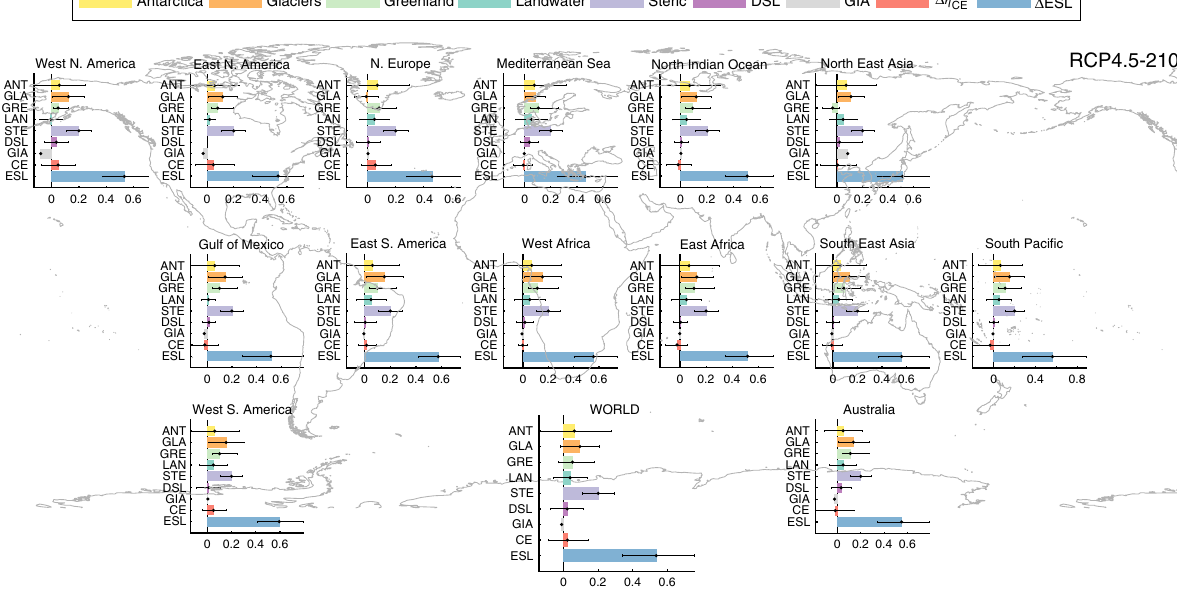
Fig. 6 Break-down of projected changes in ESL components, under RCP4.5 in 2100. Projected changes in ESL contributions from Antarctica (ANT), glaciers (GLA), Greenland (GRE), land-water (LAN), steric-effects (STE), dynamic sea level (DSL), glacial isostatic adjustment (GIA), climate extremes (CE), as well as the combined 100-year ESL. Bars express the median values, black error lines the 5 and 95% quantiles. Values shown are expressed in m and re fl ect spatial averages for 14 regions and worldwide